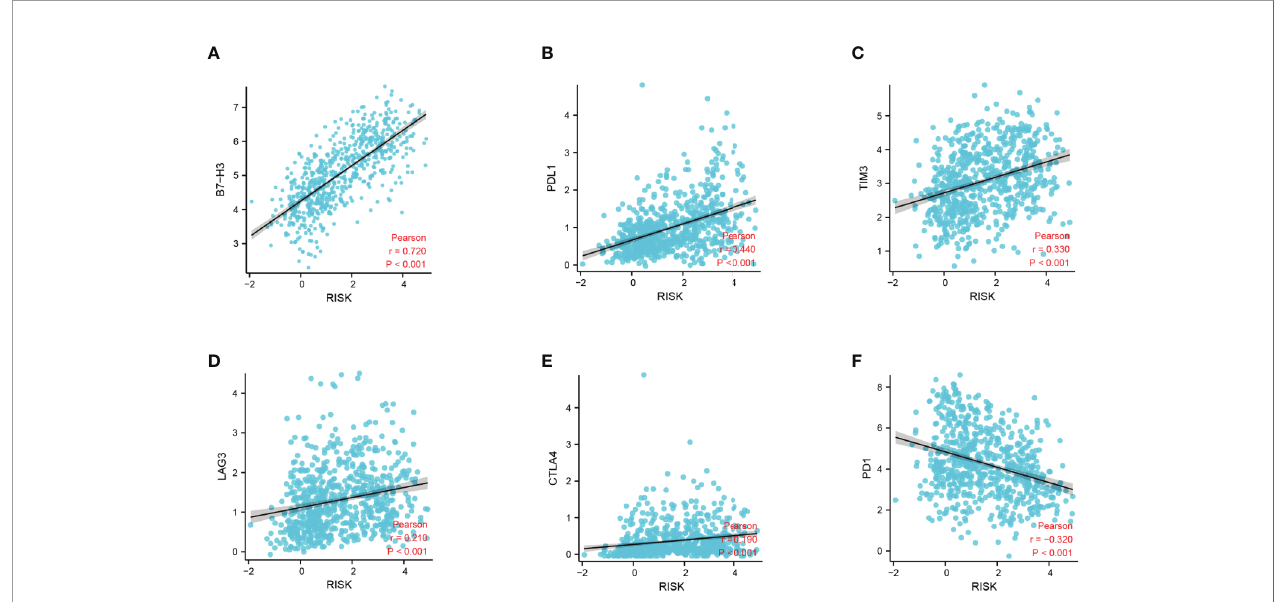
FIGURE 8 | Correlation analysis between the DDRG signature and immune checkpoints. (A – F) Relationship between the DDRG signature and B7-H3, PDL1, TIM3, LAG3, CTLA4, and PD1, respectively. CTLA4, cytotoxic T-lymphocyte associated protein 4; DDRG, DNA damage repair gene; LAG3, lymphocyte activating 3; PD1, programmed cell death 1; PDL1, programmed cell death 1 ligand 1; TIM3, T-cell immunoglobulin mucin family member